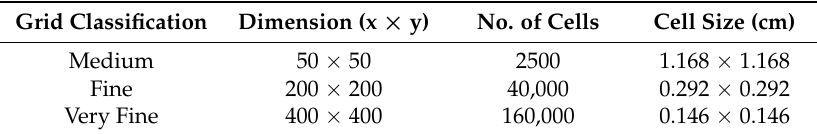
Figure 5. ( a ) Medium mesh with 50 × 50 grids, ( b ) fine mesh with 200 × 200 grids, ( c ) very fine mesh with 400 × 400 grids.